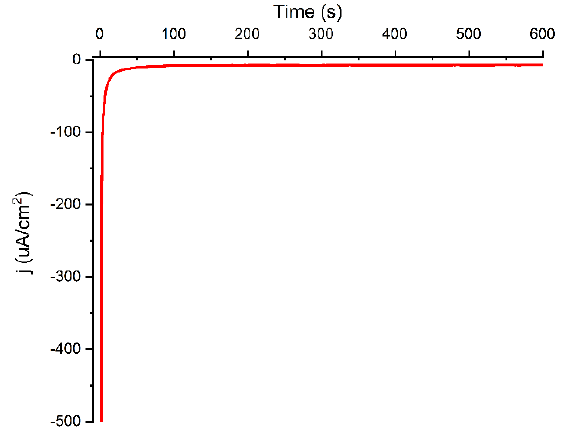
Figure 2. Chronoamperometry of 4-aminobenzoic acid with NaNO 2 . Potential peak − 0.6 V and the reduction time 600 s.